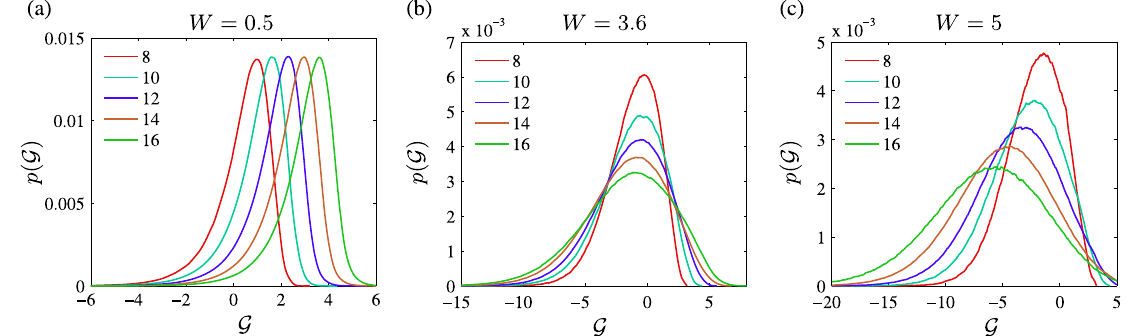
= δ Þ across the MBL transition displays qualitatively different scaling with system size. FIG. 2. The distribution of G ¼ log ðj V nn þ 1 j (a) For weak disorder ( W ¼ 0 . 5 ), when the system is in the ergodic phase, G increases with system size, and the distribution shifts to the right. (b) At the MBL transition ( W ¼ 3 . 6 ), the distribution broadens but does not move. (c) In the MBL phase ( W ¼ 5 ), G becomes smaller for larger systems, and the shape of the distribution is approximately Gaussian.